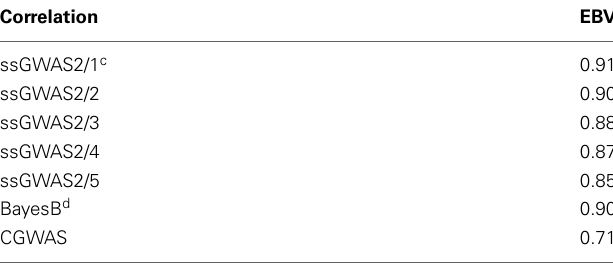
Table 1 | Correlations of EBV obtained from regular BLUP and GEBVs a obtained from three approaches b for genotyped individuals.